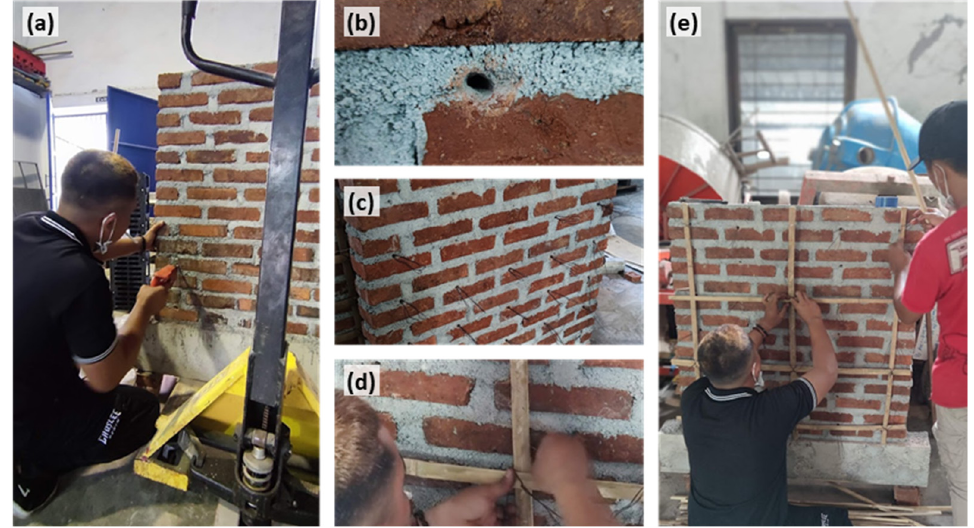
Figure 12. Preparation of the masonry panel with bamboo retrofitting: ( a , b ) boring holes on the mortar joint with specified distance, ( c ) placement of transversal wires into the holes, ( d , e ) placement of the bamboo strips on two sides of the wall and fastening using the prepared transversal wires.